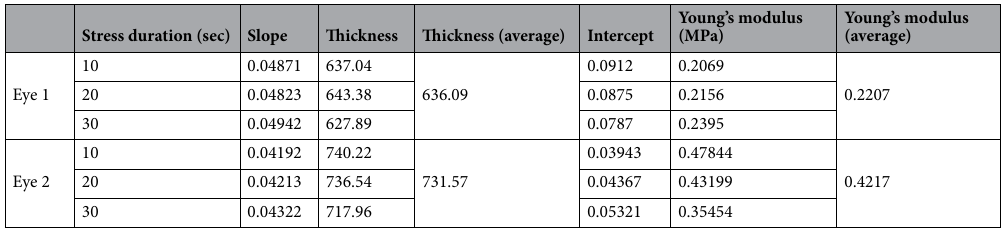
Table 3. The parameters used for calculation and the derived mechanical parameters related to cornea No. 1 and No.